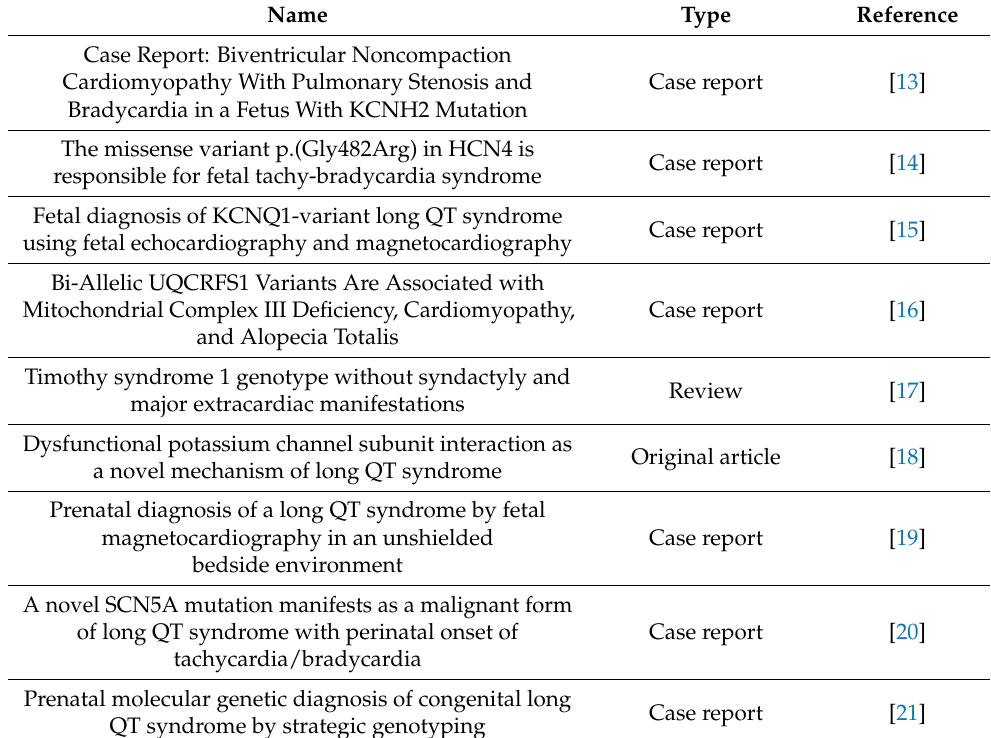
Table 1. Identified reports in the PubMed-based database search.